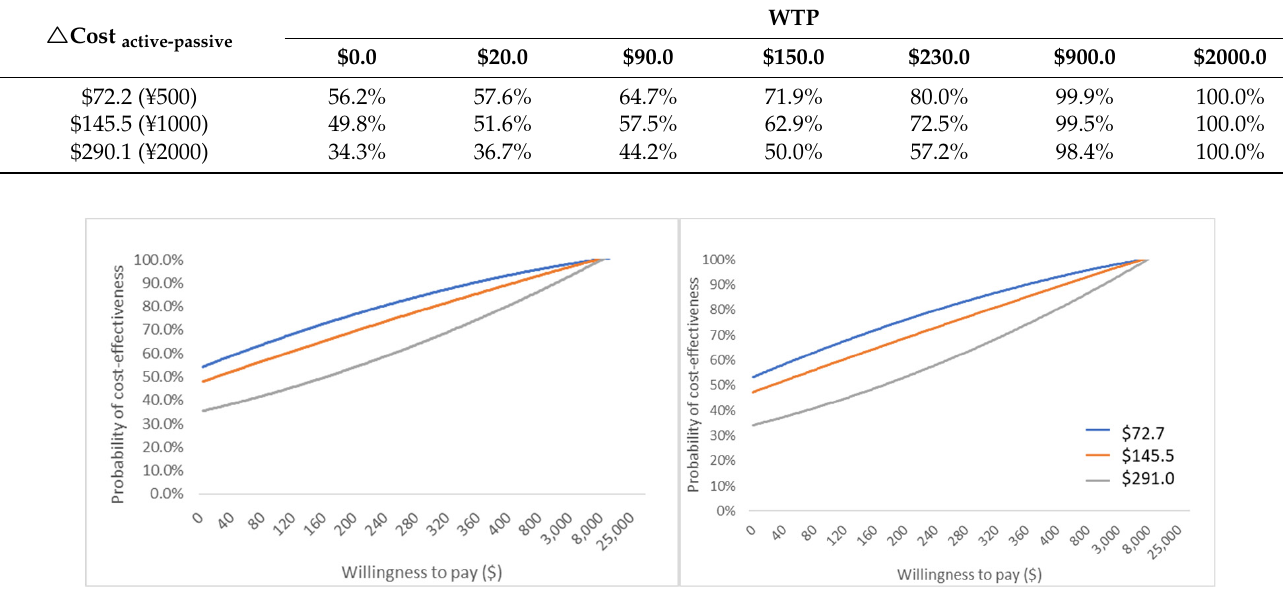
Figure 3. Cost-effectiveness acceptability curves of accepting active warming system. ( Left panel ): normal distribution; ( Right panel ): uniform distribution.